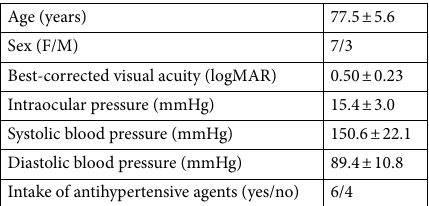
Table 1. Demographics and baseline clinical characteristics of participants. Data are shown as mean ± standard deviation.